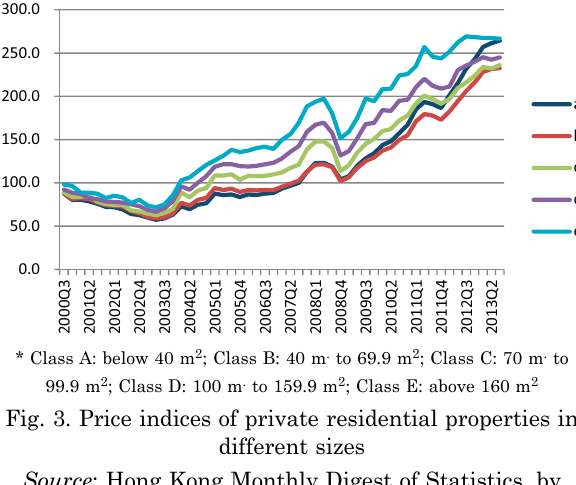
fig. 3. Price indices of private residential properties in different sizes Source : Hong Kong Monthly Digest of Statistics, by census and Statistics Department in